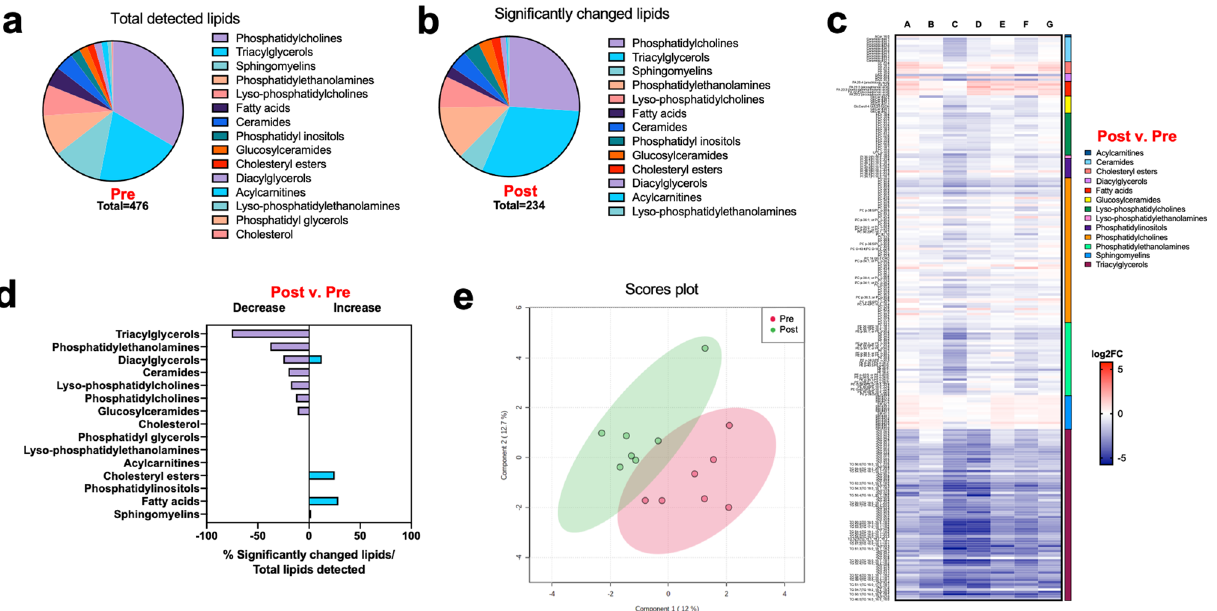
Figure 3. Fenofibrate alters lipid metabolism in diabetic dogs. ( a ) Composition of the plasma lipidome in 7 diabetic dogs at baseline, categorized by lipid groups. ( b ) Lipid groups are altered after 3 weeks of fenofibrate treatment. Significance determined when P < 0.05. ( c ) Heatmap of all differentially abundant lipid species in plasma of diabetic dogs pre- and post-fenofibrate treatment. ( d ) Percentage of lipid groups that were differentially abundant after fenofibrate administration. Significance determined when P < 0.05 and fold- change > 1.5. ( e ) Principal component analysis of the plasma lipidome in diabetic dogs pre- and post-fenofibrate administration. Circles represent regions of 95%